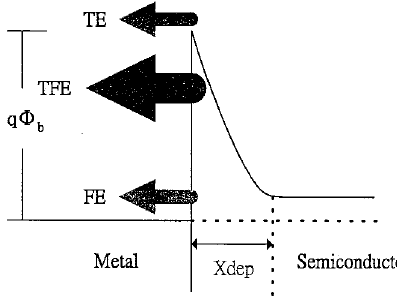
FIGURE 11 The mechanism of current transport in